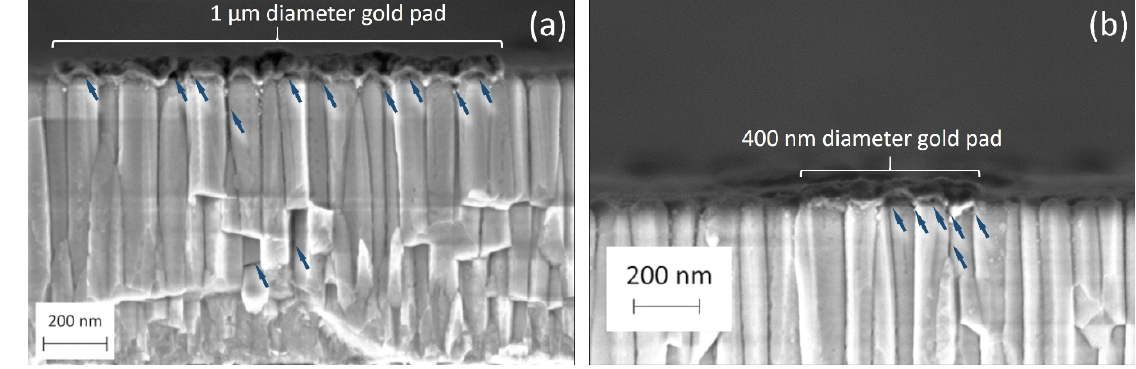
Figure 9. SEM images for cross-section PZT sample taken across ( a ) a 1 µm diameter gold pad and ( b ) a 400 nm diameter gold pad. Blue arrows points to visible voids at the interface as well as among the pillar-like bulk structure of the underlying films.